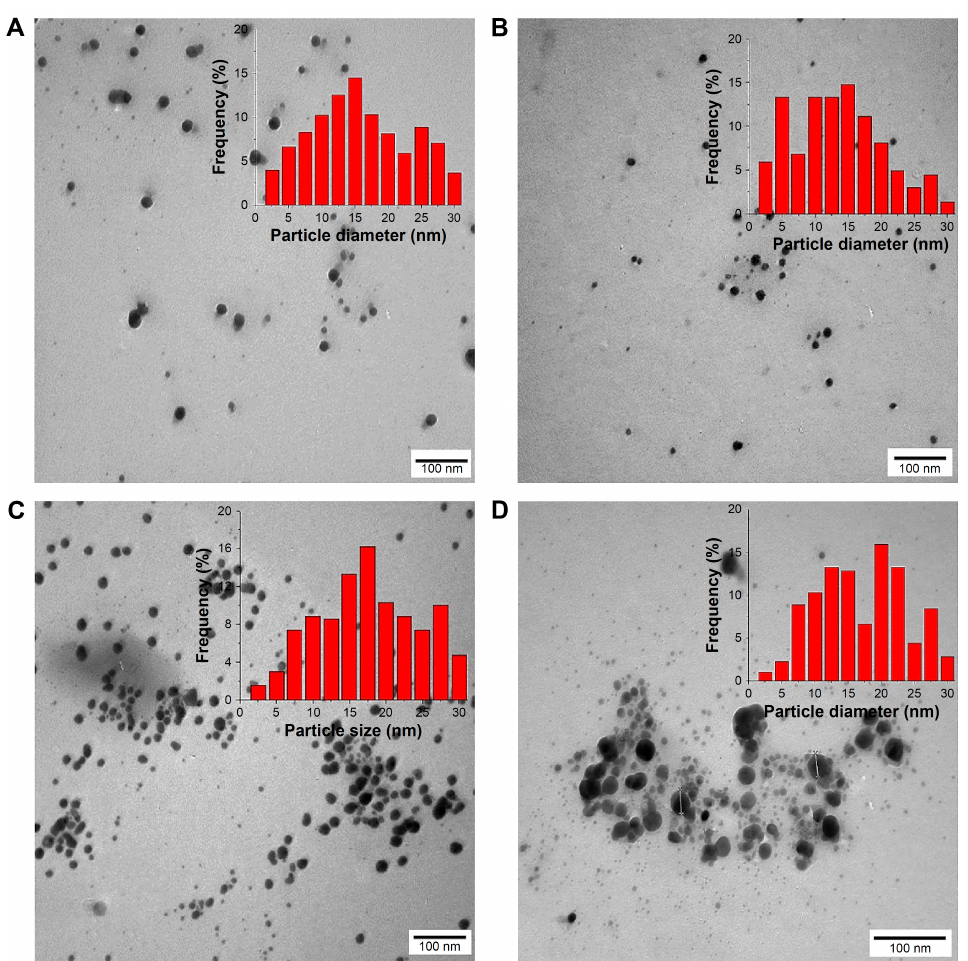
Figure 10. Representative TEM micrographs for the aqueous dried AgNPs (100 μ g AgNPs/mL): ( A ) uncoated AgNPs; ( B ) SDS-coated AgNPs; ( C ) PEG-coated AgNPs (×100,000); ( D ) β -CD-coated AgNPs (×140,000) with sizes = 15.7 ± 4.8, 13 ± 4, 19.2 ± 3.6, and 14 ± 4.4 nm, respectively ( n = 50, bar represents 100 nm). Insets indicate histograms of AgNPs size distribution. Abbreviations: TEM, transmission electron microscopy; AgNPs, silver nanoparticles; SDS, sodium dodecyl sulfate; PEG, polyethylene glycol; β -CD, β -cyclodextrin. (Reprinted from reference [52]).